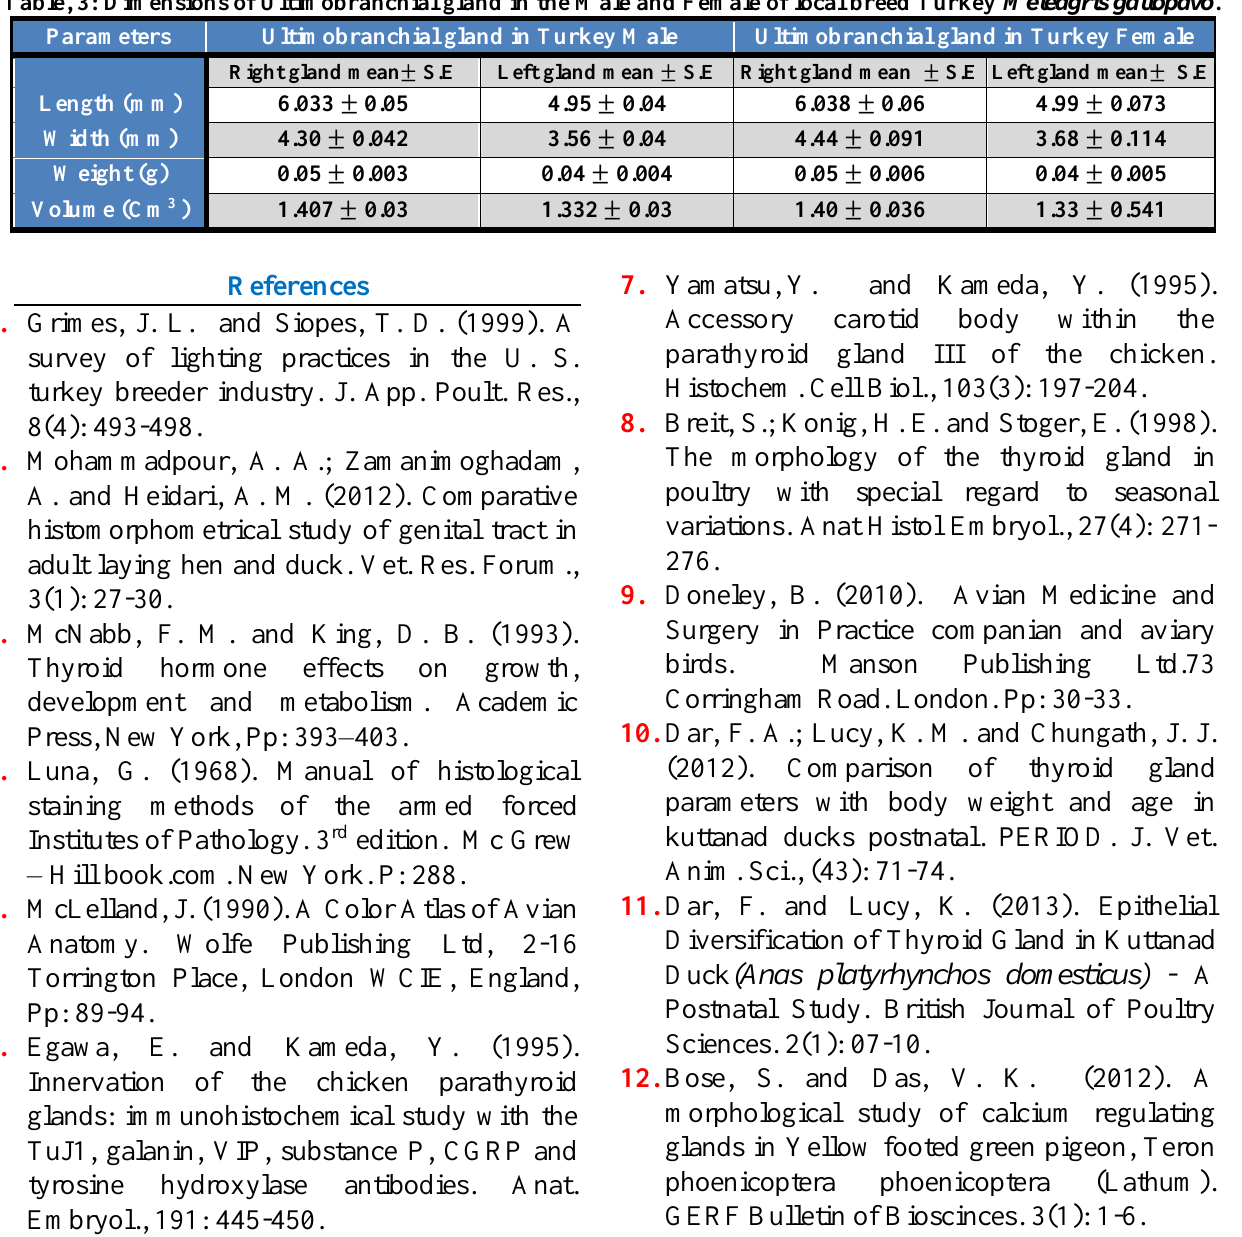
Parathyroid gland in Turkey Female Parathyroid gland in Turkey Male Parameters